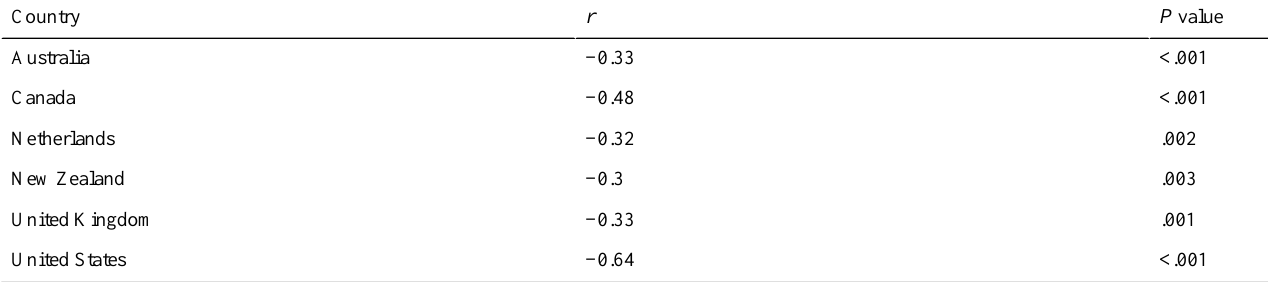
Table 1. Results of the Pearson coefficient test between interest levels for the terms ‘‘school closure’’ and ‘‘suicide’’ based on Google Trends data from countries that showed a significant relationship between interest